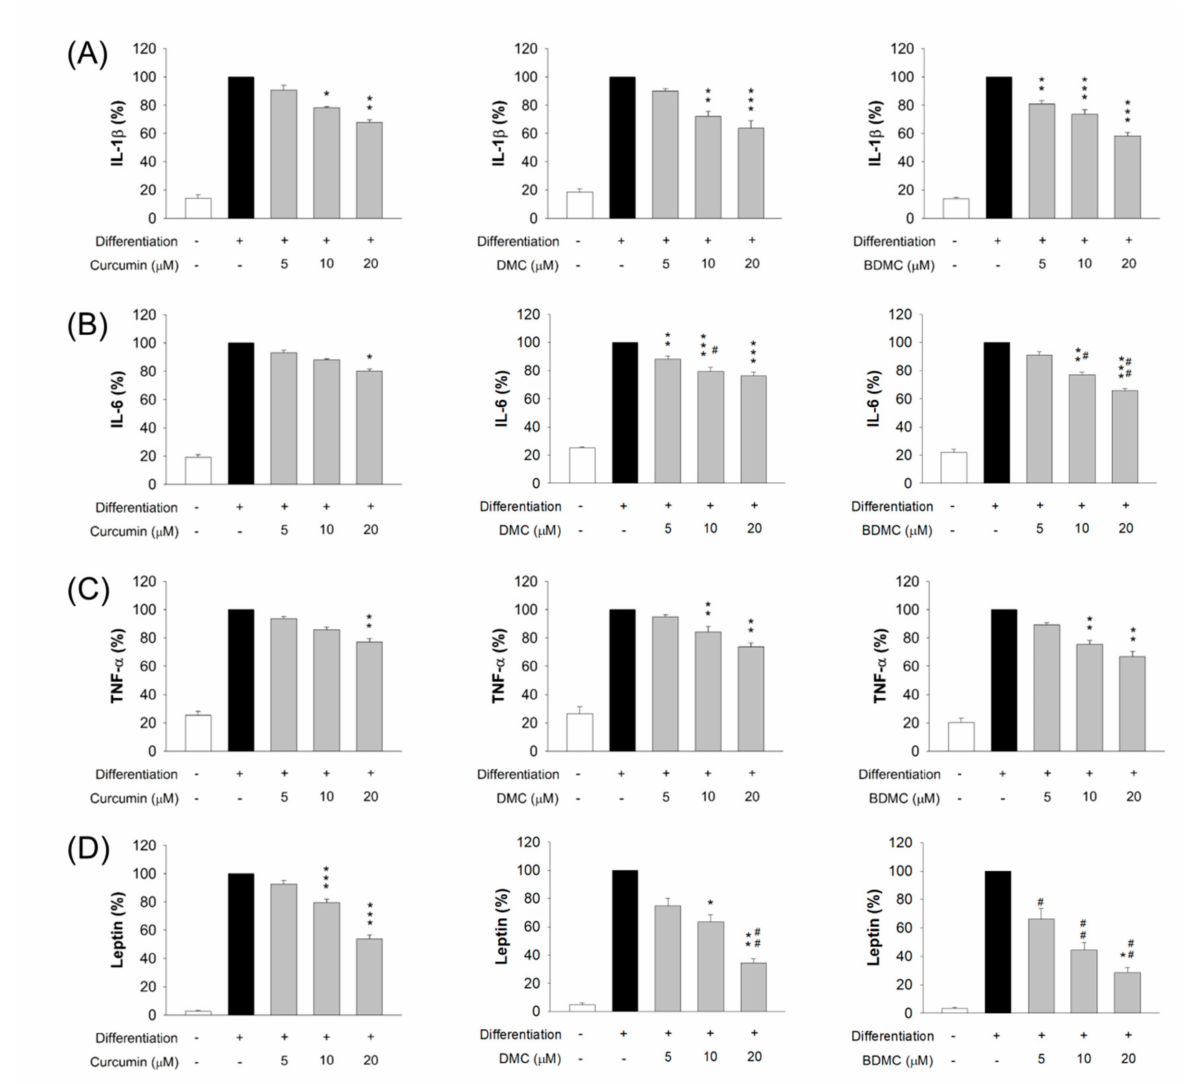
Figure 6. The effect of curcuminoids on adipokines of 3T3-L1 cells. ( A ) The protein expression of IL-1 β after treatment of curcuminoids at 0 − 20 µ M; ( B ) the protein expression of IL-6 after treatment of DMC at 0 − 20 µ M; ( C ) the protein expression of IL-1 β after treatment of BDMC at 0 − 20 µ M; and ( D ) the protein expression of leptin after treatment of curcuminoids at 0 − 20 µ M. All data are presented as the mean of three experiments ± S.E.M. *** p < 0.001; ** p < 0.01; * p < 0.05 as compared to the differentiated control group. ## p < 0.01; # p < 0.05 as compared to the curcumin-treated group at the same